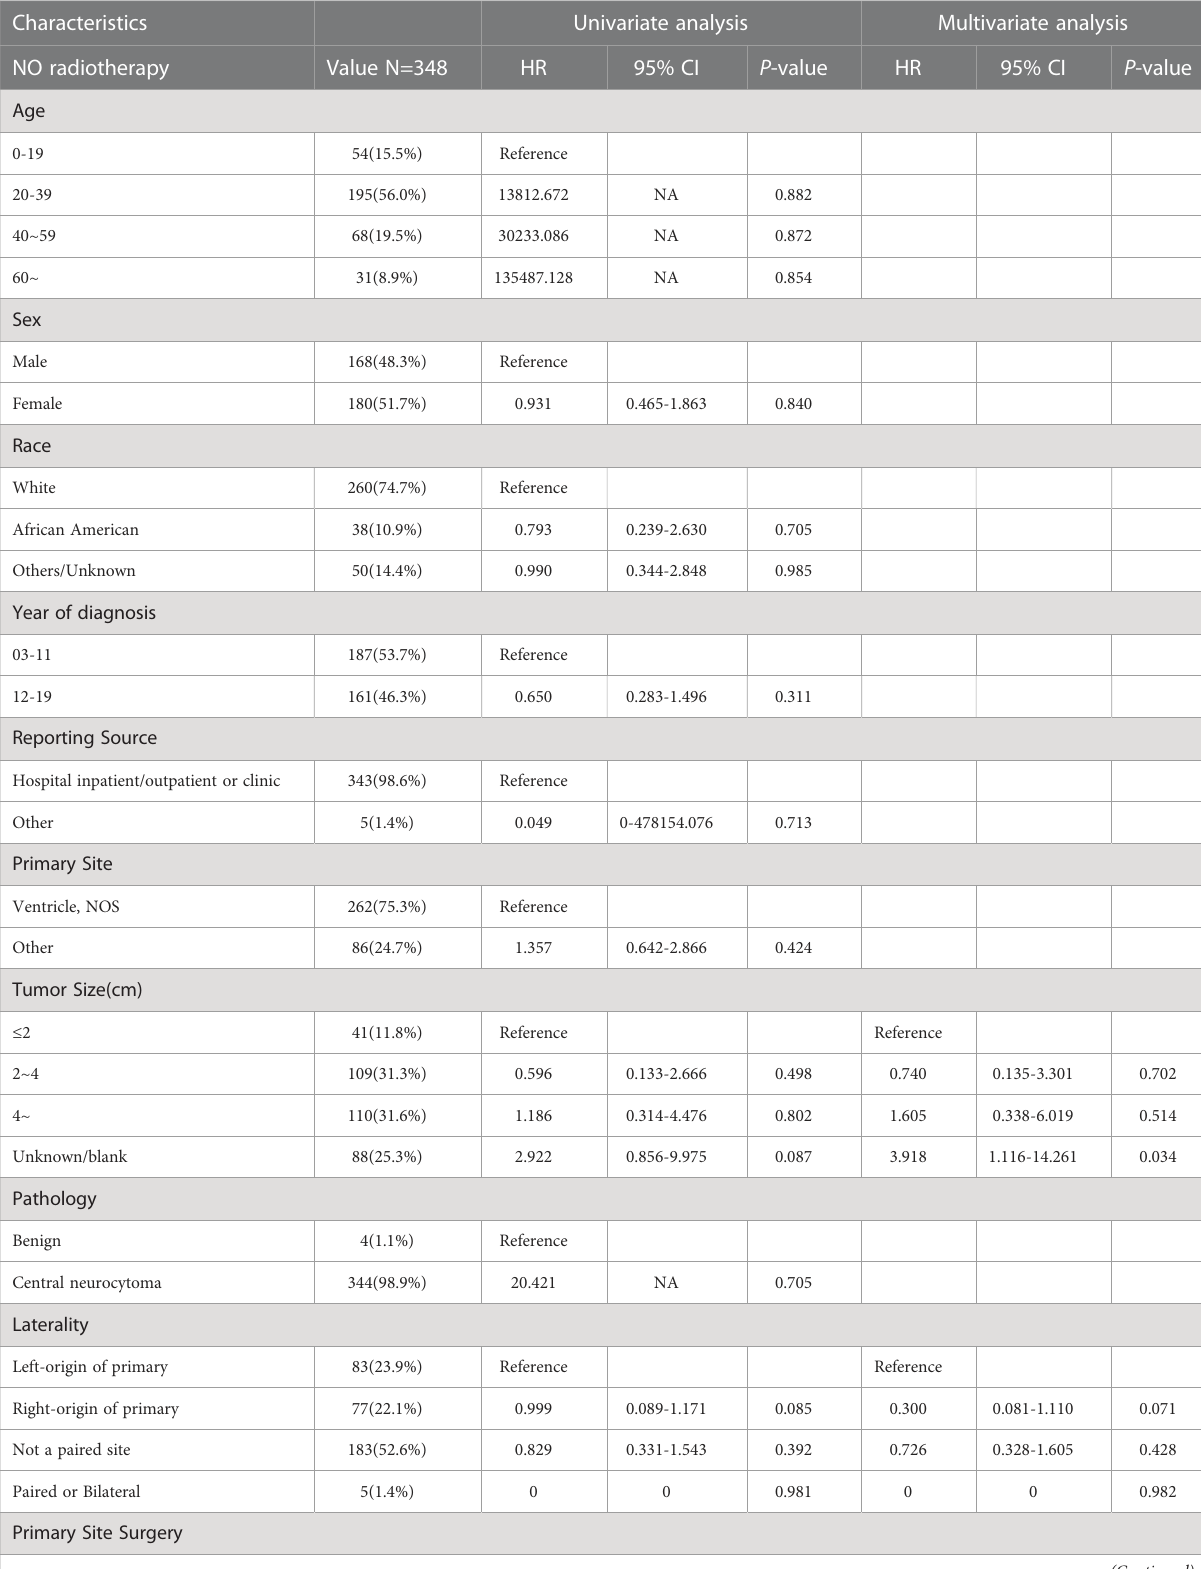
TABLE 6 The median overall survival (OS) of the no radiotherapy subgroup was 79 (interquartile range (IQR): 38.25 – 132)